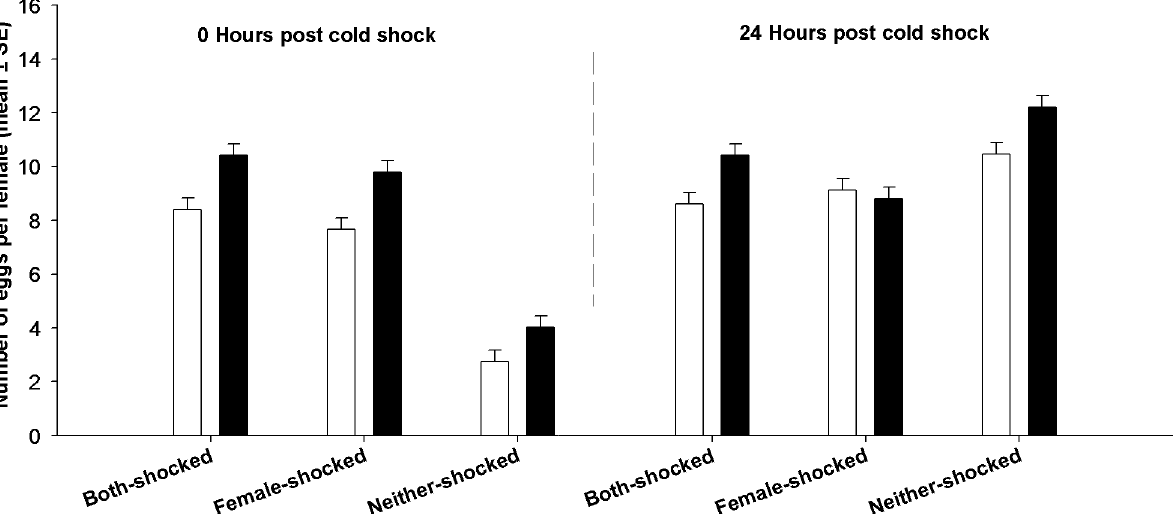
Fig 2. Effect of cold shock on egg viability. We assayed egg viability 0 and 24 hours post cold shock. Open bars represent FCB and black bars represent FSB populations. Viability of eggs from Neither-shocked treatment was high and not different between FCB and FSB populations. At 0 hours post cold shock, viability of eggs from the Both-shocked and Female-shocked treatment was very low and not different between FCB and FSB populations. By 24 hours post cold shock, egg viability improved and the FSB populations had significantly higher egg viability than the FCB